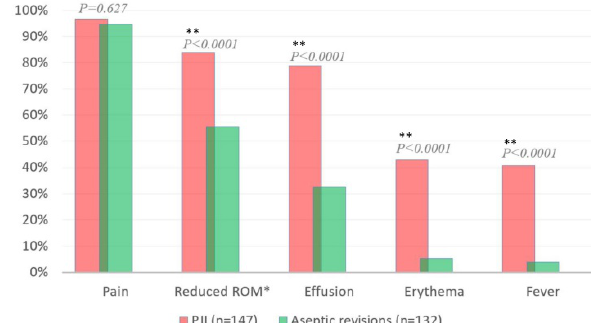
Figure 1. Clinical presentation in septic compared to aseptic revisions. Periprosthetic Join Infection (PJI); Range of Motion (ROM) * Information on range of motion was available for 175 patients (56 septic and 119 aseptic). ** Significant